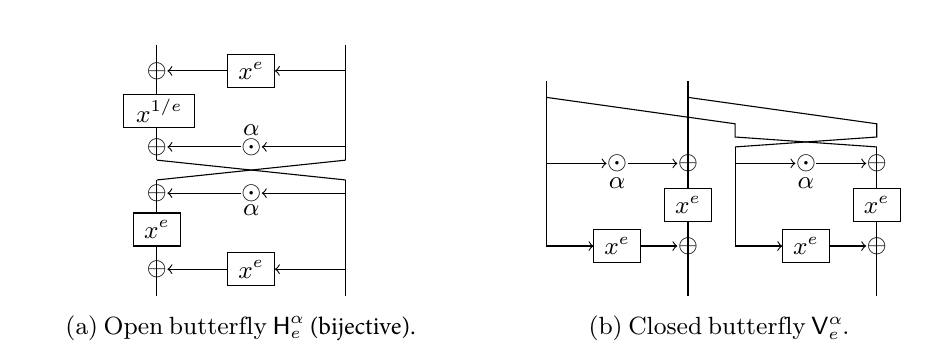
Fig. 11: The two types of butterfly structure with coefficient 𝛼 and exponent 𝑒 . Figure 1: The butterfly